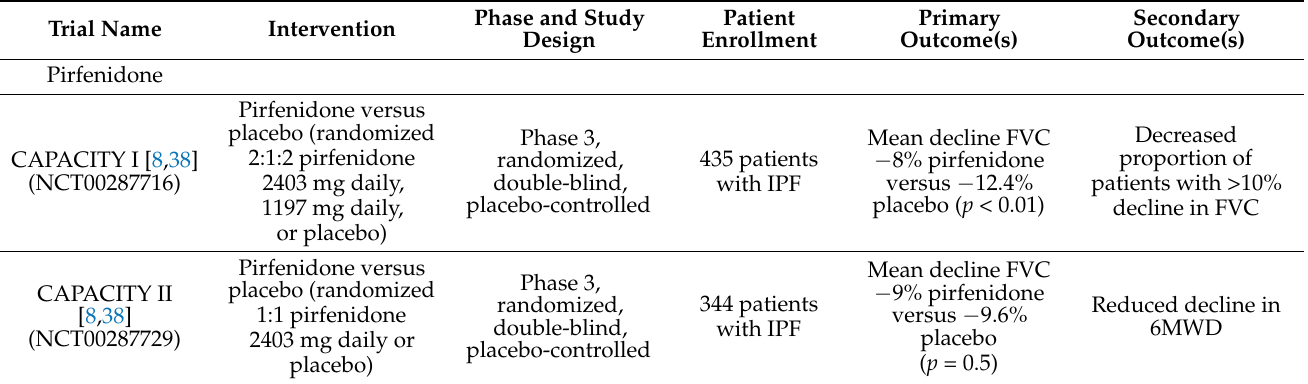
Table 2. List of major antifibrotic trials that have included pirfenidone as an intervention. 6MWD: Six-minute walk distance; DLCO: Diffusing capacity for carbon